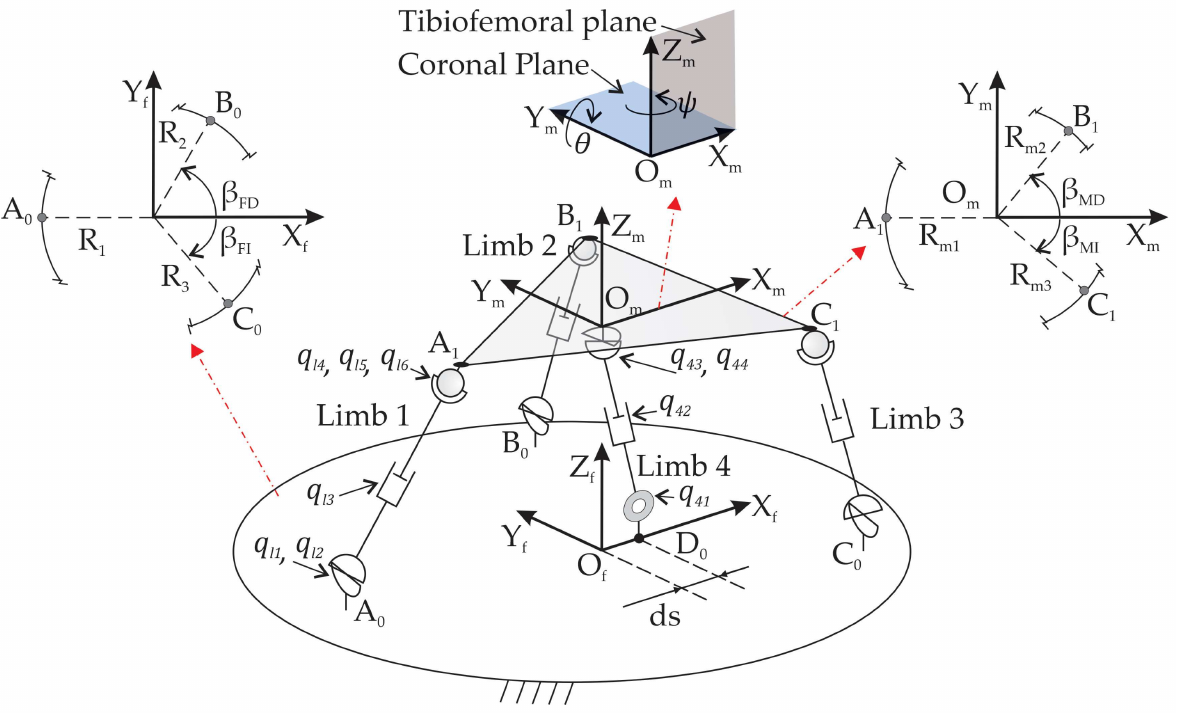
Figure 1. Mechanical configuration of the 3UPS+RPU